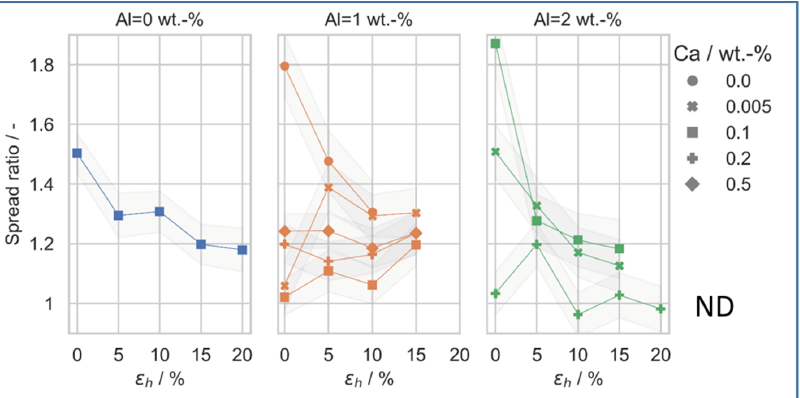
Figure 5. Spread ratio of the peak shape related to the relative height reduction ( ε h ) towards rolling direction (RD)/TD of the pole figures for S_ND samples, including the error in the spread towards RD and TD estimated at 1.75° (half of the resolution).